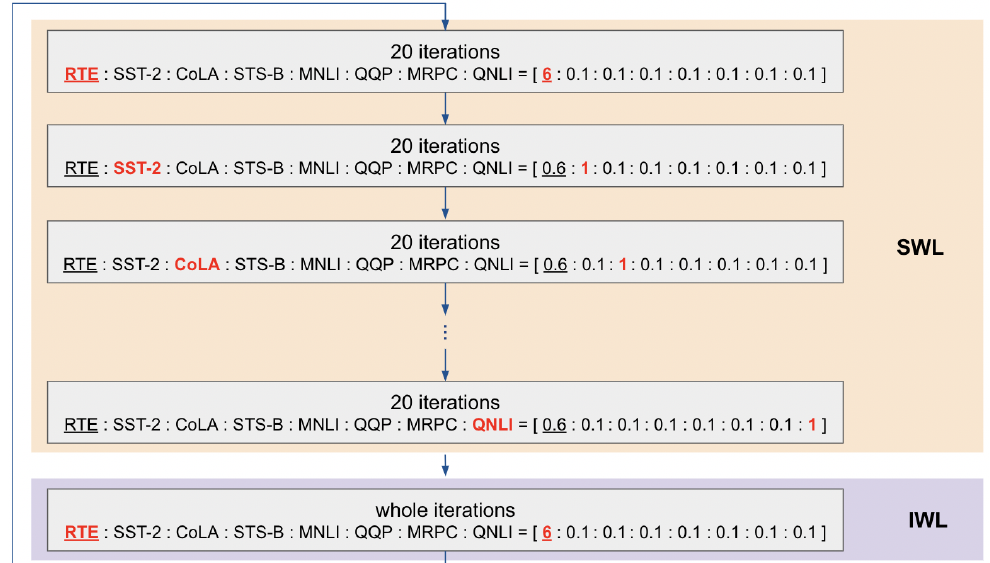
Figure 2. Example of weight-adjustment process applied to loss weighted sum. In this example, RTE is the central task and is underlined in the figure. The focusing tasks in the SWL stage are indicated by the bold red font. For each epoch, the SWL and IWL stages are applied alternately. In the SWL stage, the focusing task is changed every 20 iterations and the initial weight of each task except the focusing task is multiplied by 0.1. In contrast, in the IWL stage, the central task is fixed as a focusing task and the initial weights of all auxiliary tasks are multiplied by